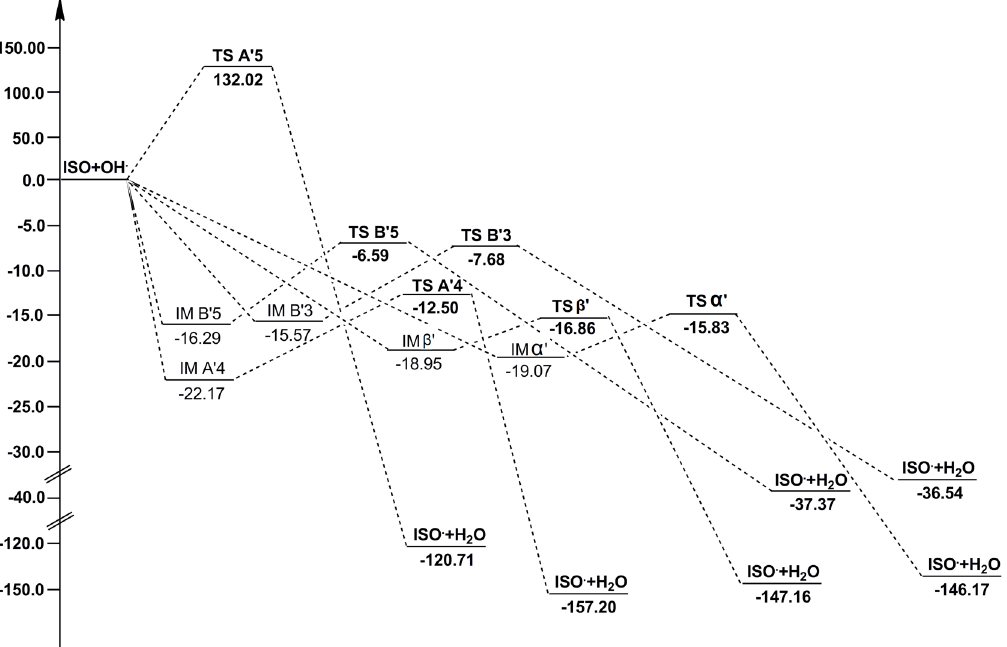
Fig 5. The potential energy surfaces of the reactions of ISO with (cid:129) OH in the gas phase. The relative energies (in kJ/mol) were calculated at the M05-2X/ 6-311++G(d,p) + ZPE level. To facilitate comparison, the energy of the reactants are set to